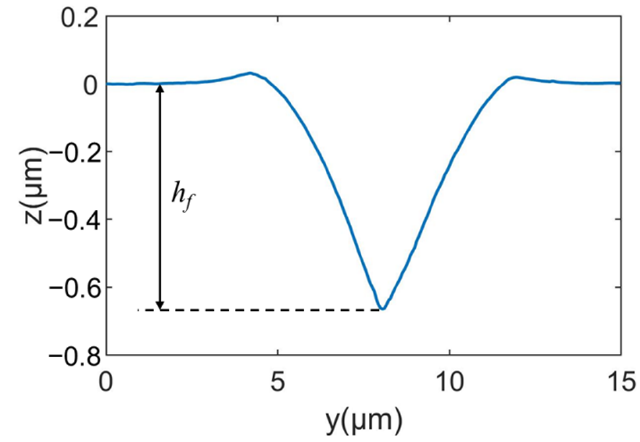
Figure 4. The AFM-measured three-dimensional topography of the scratching impression induced by an edge-forward Berkovich indenter under the normal load of 200 mN.